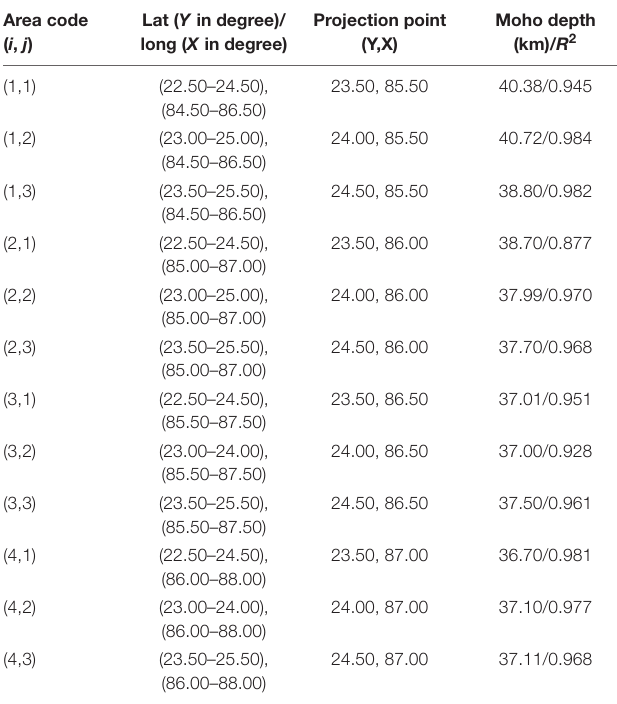
R 2 : coefficient of determination, i.e., fitness of the best fit line on